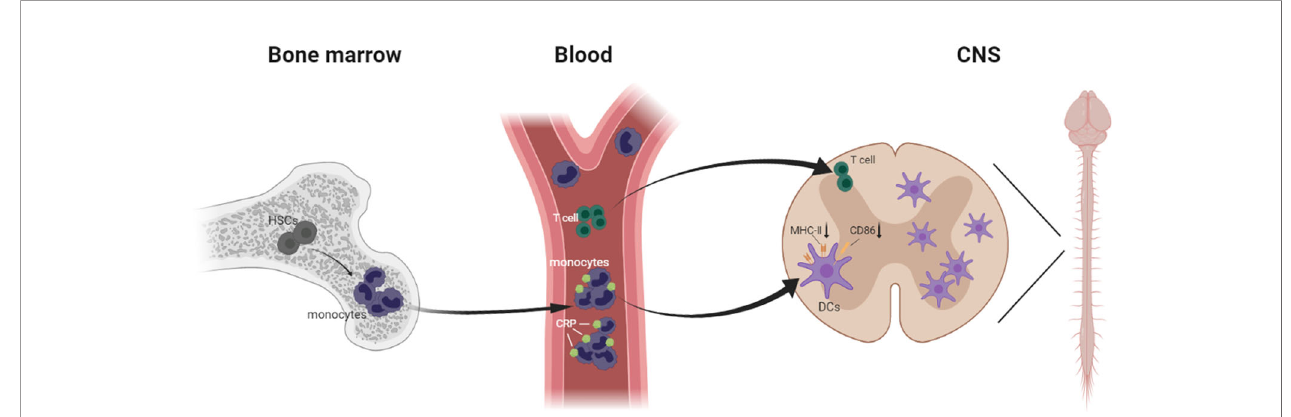
FIGURE 8 | Schematic model demonstrating immune cells in fi ltrating from the bone marrow to the CNS in